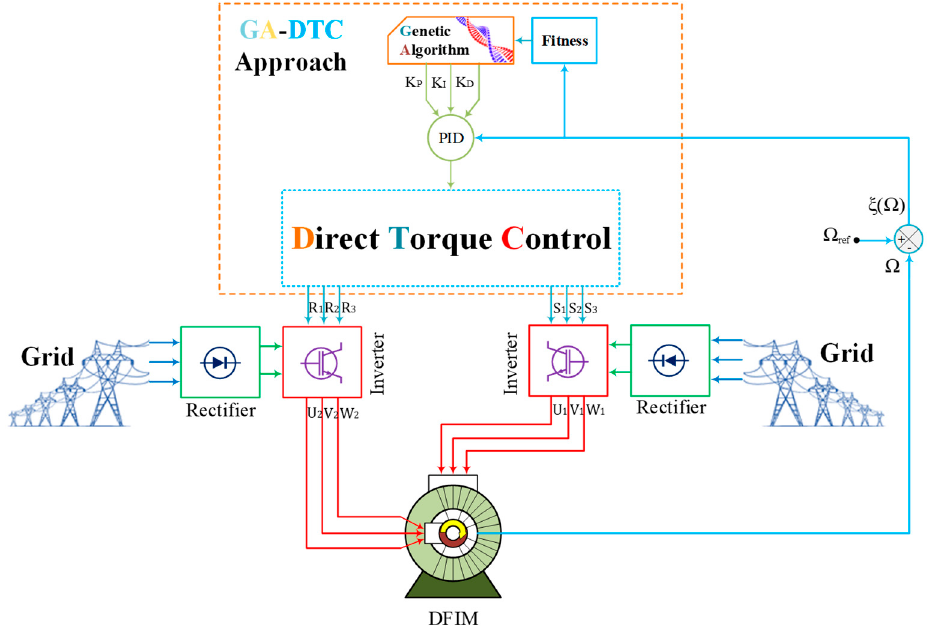
Figure 1. Proposal structure of DTC based on GA for DFIM.